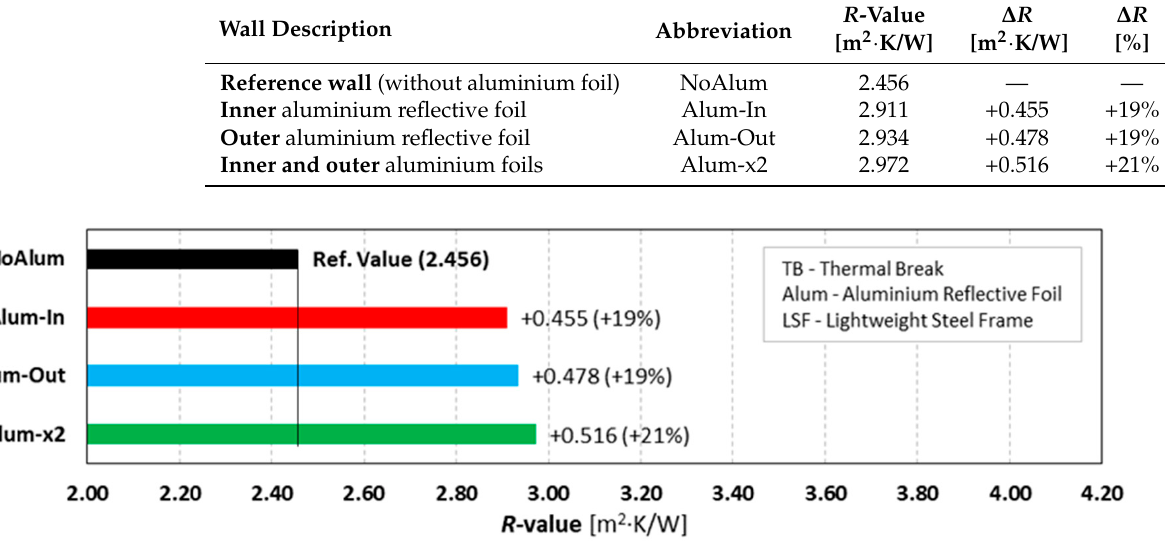
Figure 7. Measured thermal resistance improvement due to aluminium reflective foils. Table 5. Measured thermal resistance of double-pane LSF walls and thermal performance improvement due to aluminium reflective